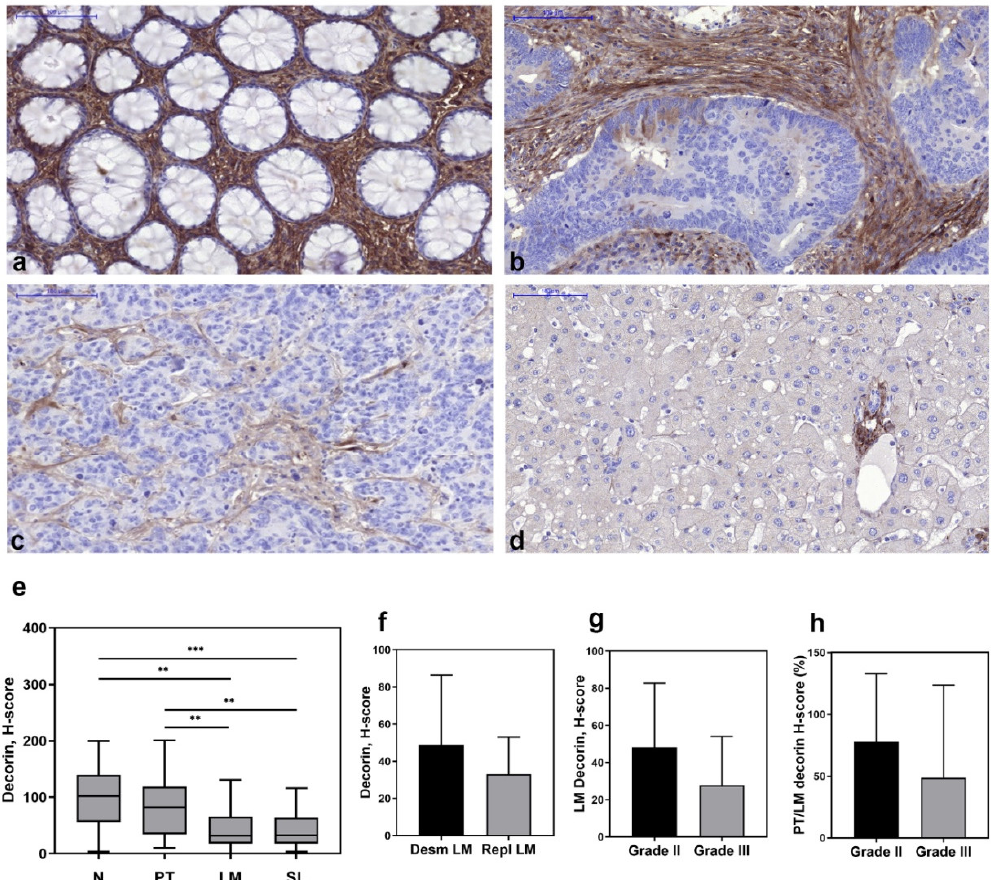
Figure 1. Immunohistochemistry of decorin in normal colon ( a ), colorectal cancer ( b ), liver metastasis ( c ), and surrounding liver tissue ( d ). Decorin expression in primary tumor stroma is usually high ( b ); however, liver metastasis of the same tumor often displays a reduced amount of the proteoglycan ( c ). Bar charts represent the amount of decorin ( n = 30) ( e ). Decorin level is lower in the replacement type of metastases than those of desmoplastic ones ( f ). Metastases of grade III tumors are characterized with lower decorin expression compared to grade II CRC ( g ). Grade III metastases contain less decorin in their paired primary tumors than those of grade II shown by relative decorin levels ( h ). N = Normal colon, PT = primary tumor, LM = liver metastasis, SL = surrounding liver, Desm = desmplastic type of LM ( n = 20), Repl. = replacement type of LM ( n = 10). Grade II: n = 23, grade III: n = 6. Scale bar = 100 µ m. Data are presented as mean (S.D.). ** p value < 0.01; *** p value <